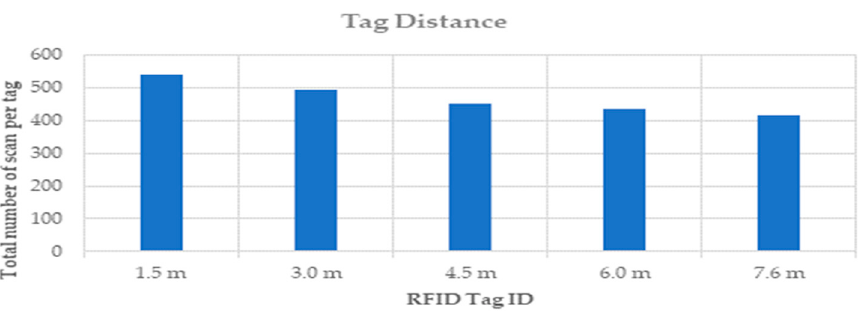
Figure 11. The total number of scans per tag for each type and orientation per 3 min in a laboratory.